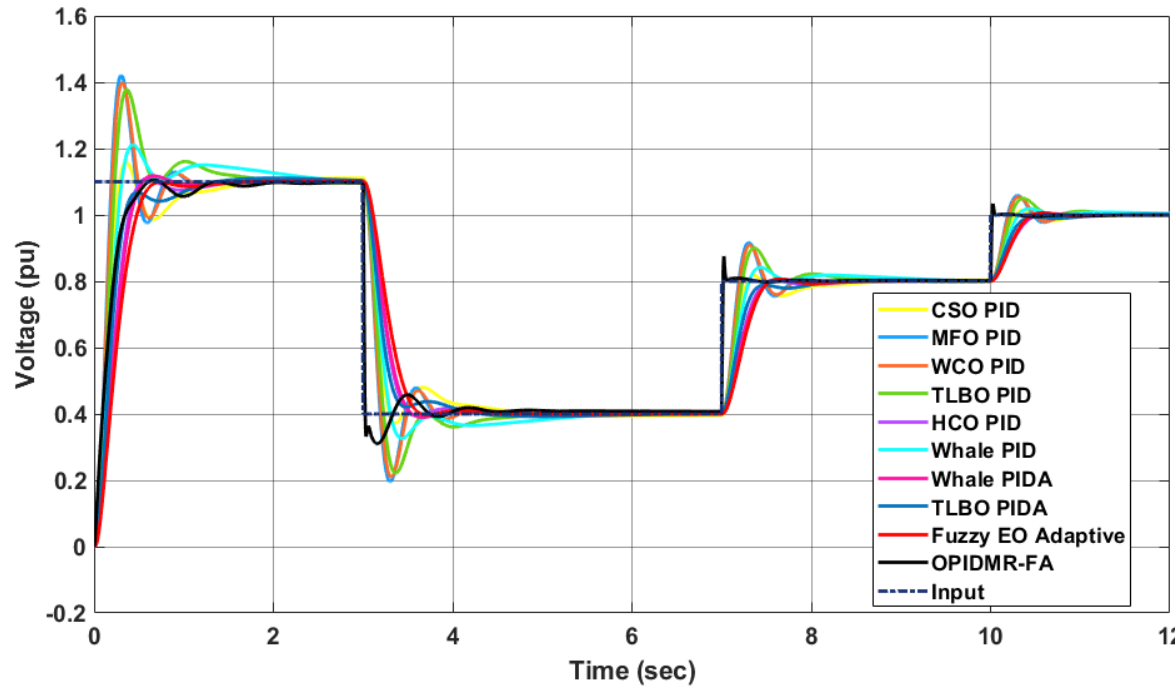
Figure 12. Magnified view of Figure 11.